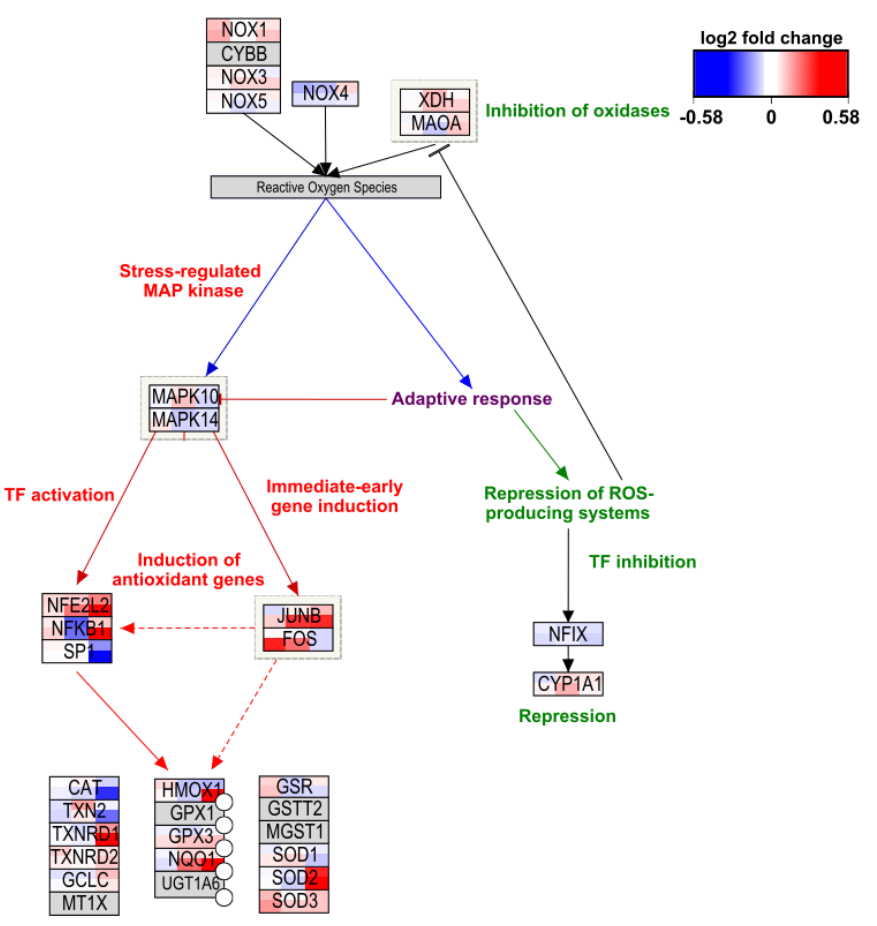
Figure 3. Visualization of log fold change on the Oxidative Stress pathway (wikipathways:WP408) for all six conditions. Cellular models are depicted from left to right as Caco-2/HT29-MTX, SAE, and THP1. The top row depicts the low concentrations whereas the bottom row depicts the high concentra- tions. Color gradient for differential gene expression after exposure goes from blue (downregulated) via white (not changed) to red